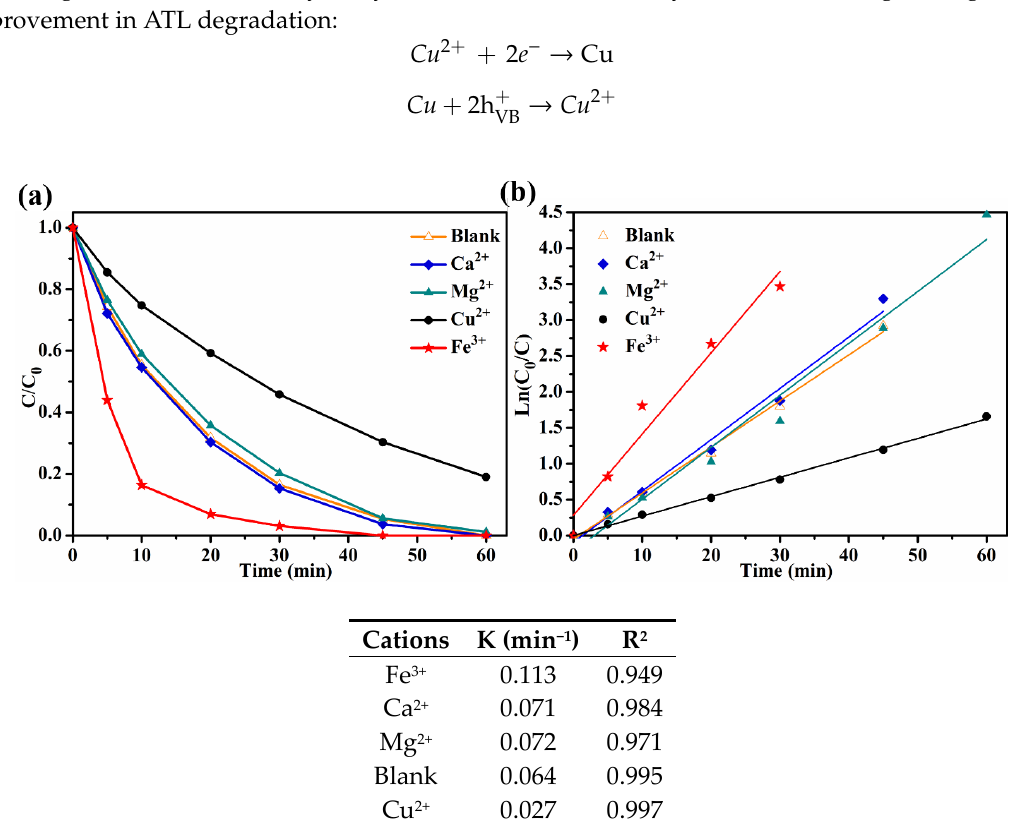
Figure 10. ( a ) Effect of co-existing cations in water on ATL degradation. ( b ) Pseudo- first-order